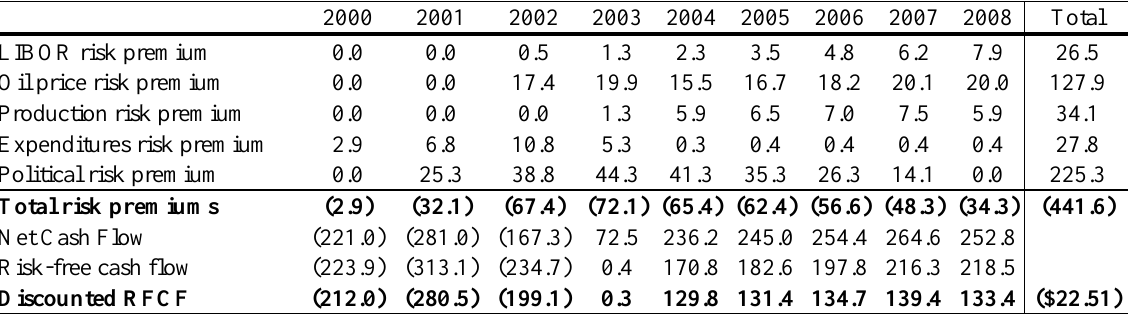
Table 6. M-DNPV analysis - Risk-free cash